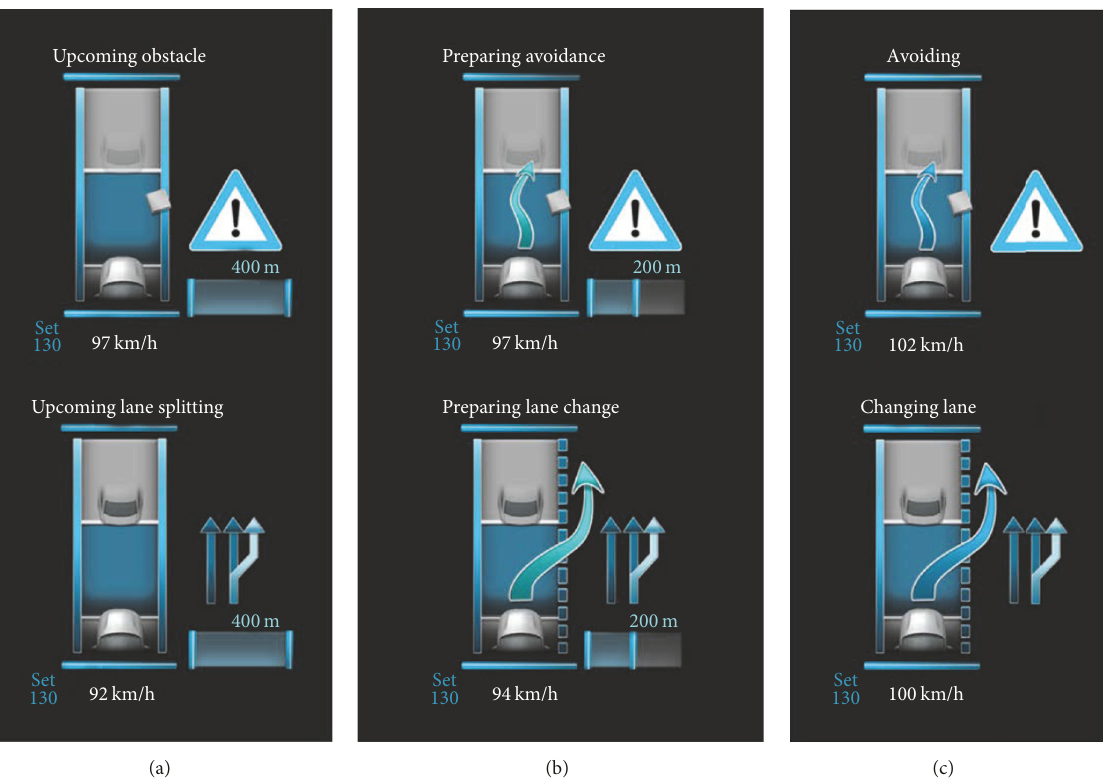
Figure 3: HMI for communication of driving manoeuvres. Announcement stage (a), preparation stage (b), and execution stage